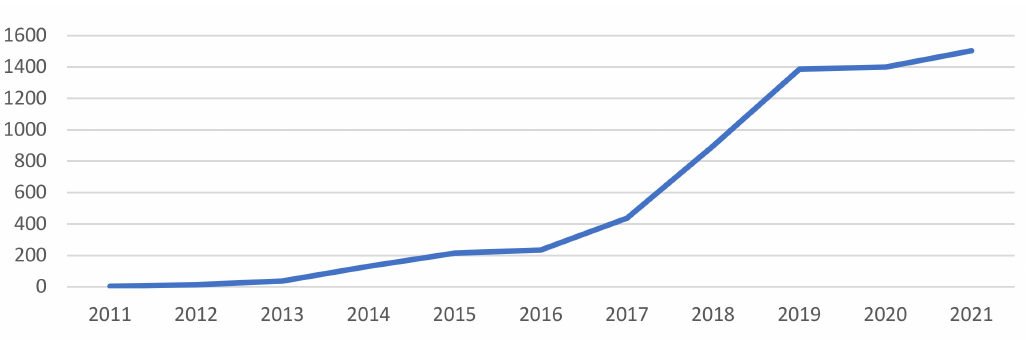
Figure 1. The dynamic of publications on researching cryptocurrency development (Scopus